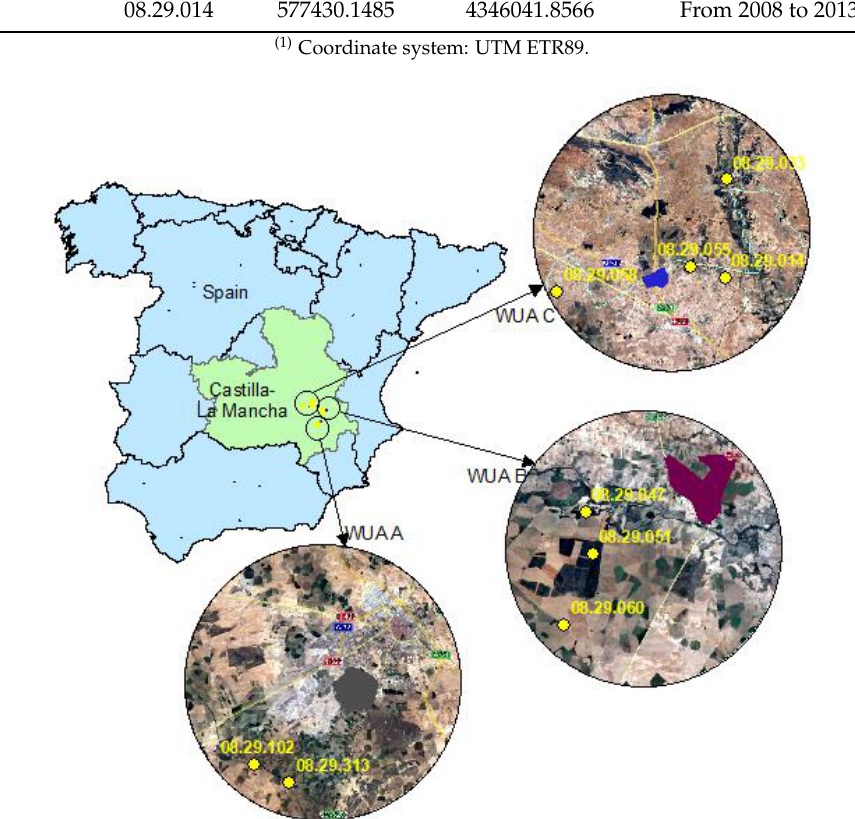
Figure 2. Location of the piezometers and analyses at Irrigation Society A ( a ), B ( b ), and C ( c ).